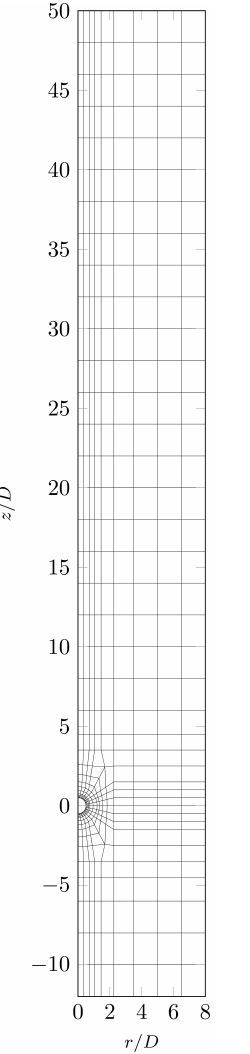
Figure 1. Spectral-element mesh in the axial–radial plane, where the lines depict the boundaries of the 463 elements. Each element contains [ 6 × 6 ] collocation points. The three-dimensionality is in- troduced by Fourier expansion in the azimuthal direction, which is truncated at the seventh Fourier mode, resulting in a cylindri- cal domain. A uniform velocity profile with constant temperature and vapor content is imposed at the upstream boundary, while the downstream boundary is subject to zero-gradient boundary condi- tions (BCs) for both velocity and scalars. The lateral boundaries are stress-free at zero pressure, with zero-gradient BCs for the scalars. The surface of the spherical particle, whose center is located at the origin of the coordinate system, is impermeable, and a no-slip BC for velocity is imposed, as well as constant Dirichlet BCs for the scalar